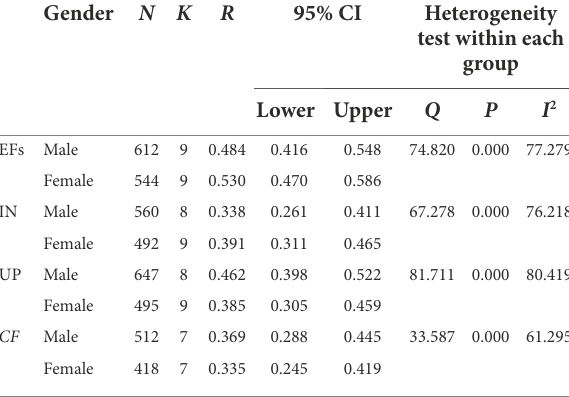
TABLE 3 The moderating effect of gender on executive functions and mathematical competence in preschool children. Gender N K